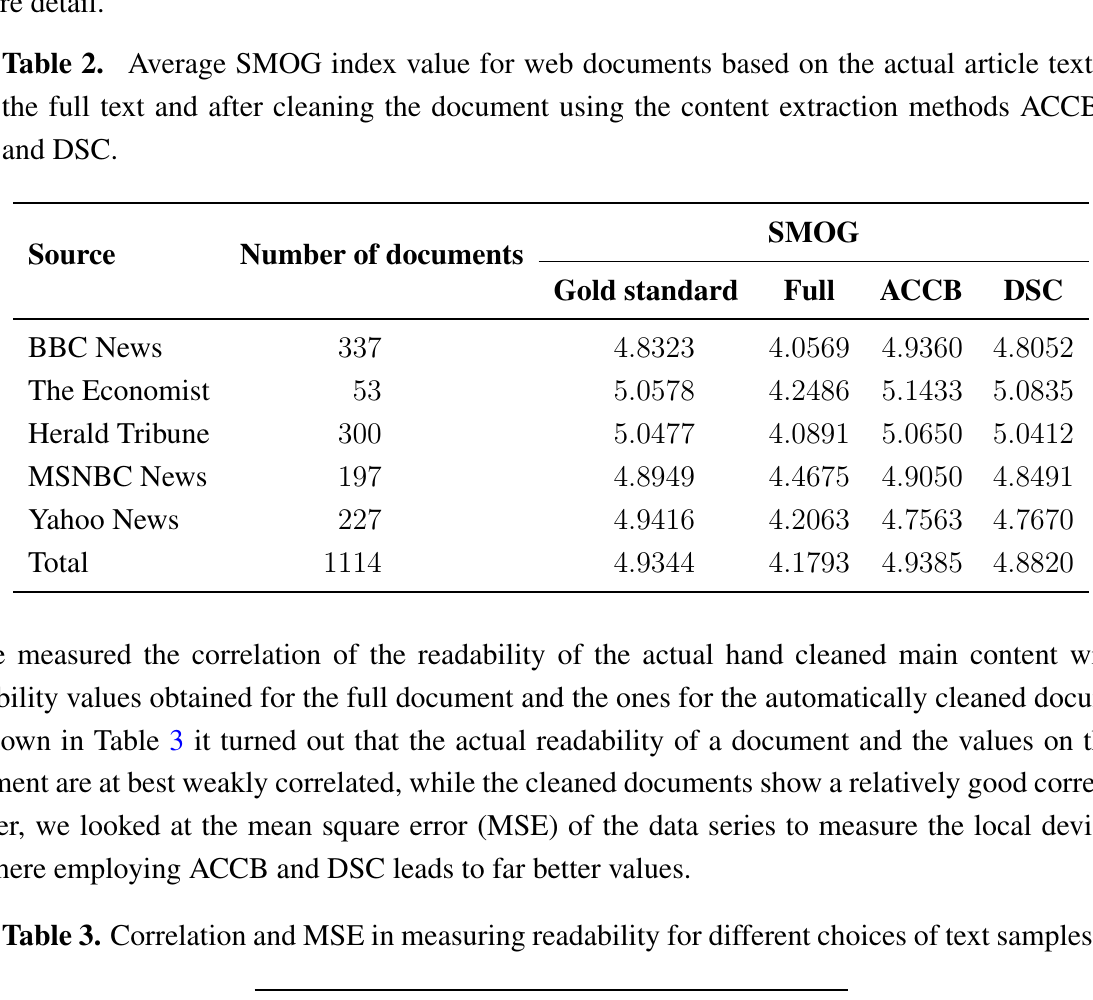
Table 3. Correlation and MSE in measuring readability for different choices of text